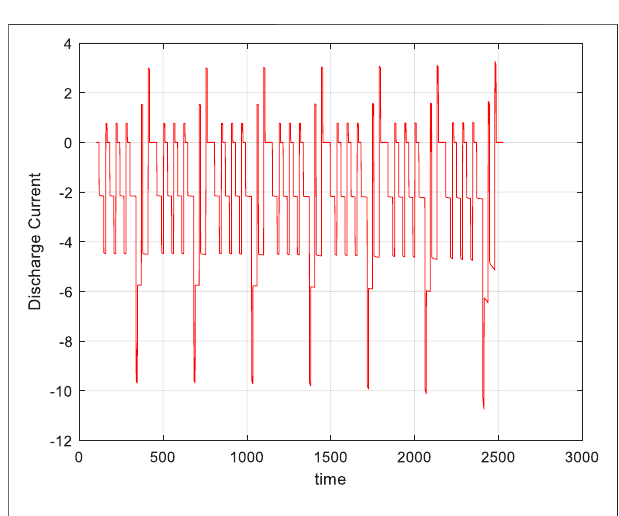
FIGURE 14 | Current under DST